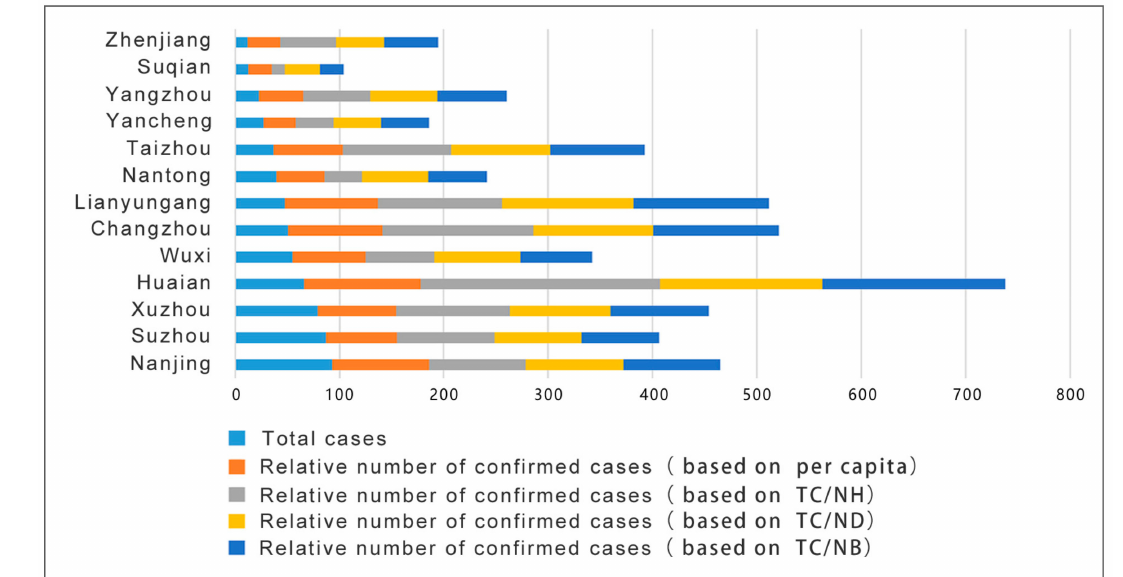
Figure 2. Pandemic crisis index map of each city in Jiangsu Province.